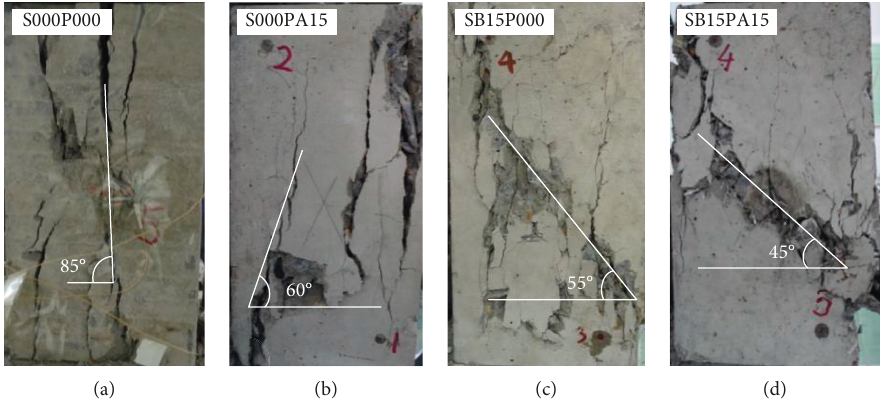
Figure 5: Typical failure modes for concrete